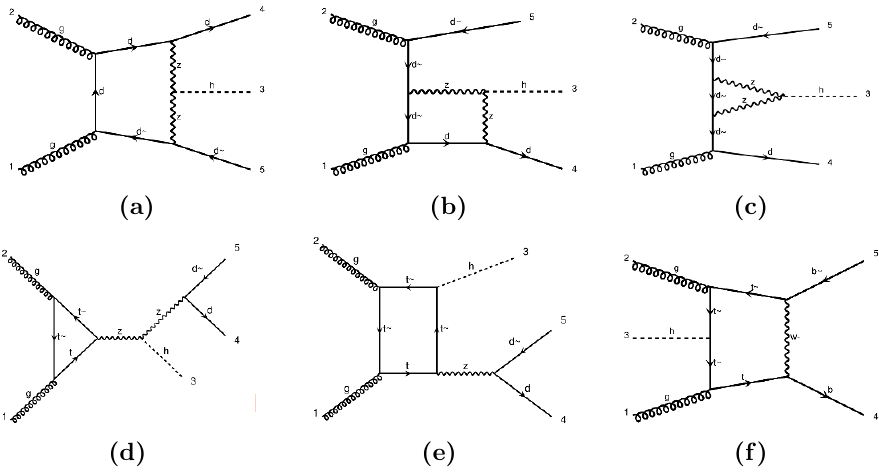
Figure 1 . Representative subset of diagrams contributing to the amplitude A (0 ; 2) . In dia- gg ! Hq (cid:22) q grams 1a, 1b and 1c, the Z boson can be interchanged with a W boson. Diagrams 1d and 1e are contributions to the production of a Higgs in association with a Z boson and are only included in the computation of (cid:27) (1 ; 1) , and not that of (cid:27) (1 ; 2) . Diagrams of the class 1f are only present pp ! H + X pp ! H + X Hb (cid:22) b for the process gg !